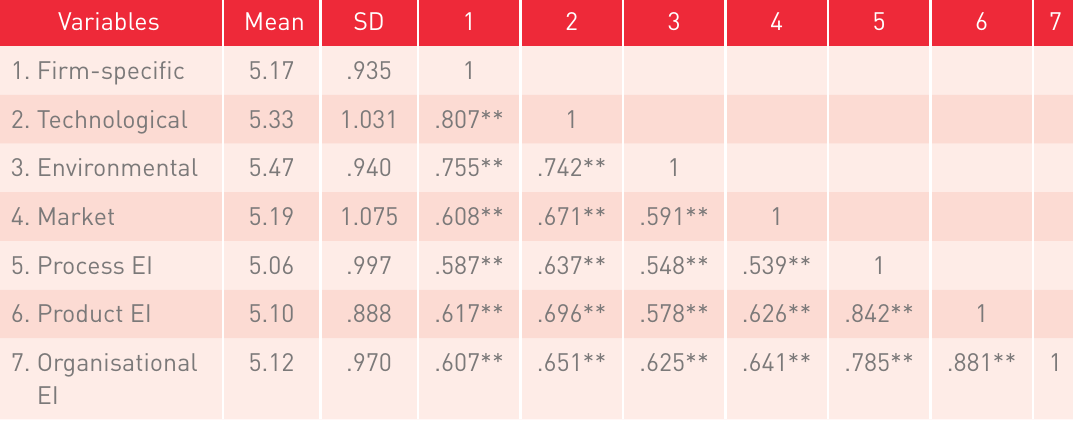
Pearson Correlation Coefficient matrix of EI practices and driving